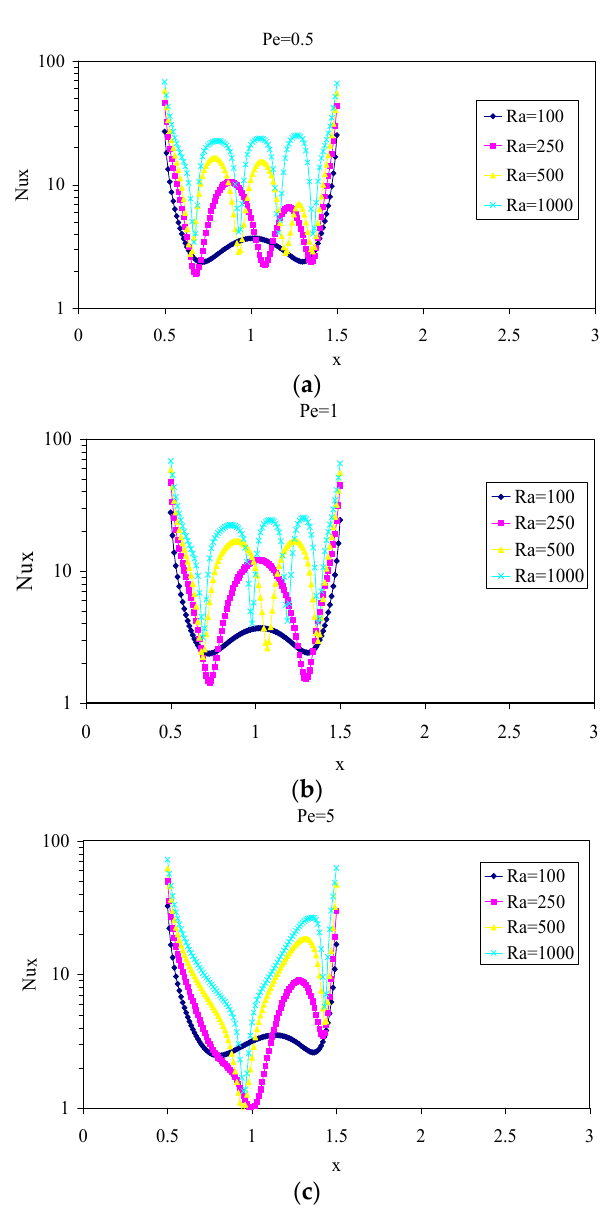
Figure 6 Variation of local Nusselt number along the channel ( c = 0.33), ( a ) Pe = 0.5, ( b ) Pe = 1, ( c ) Pe = 5